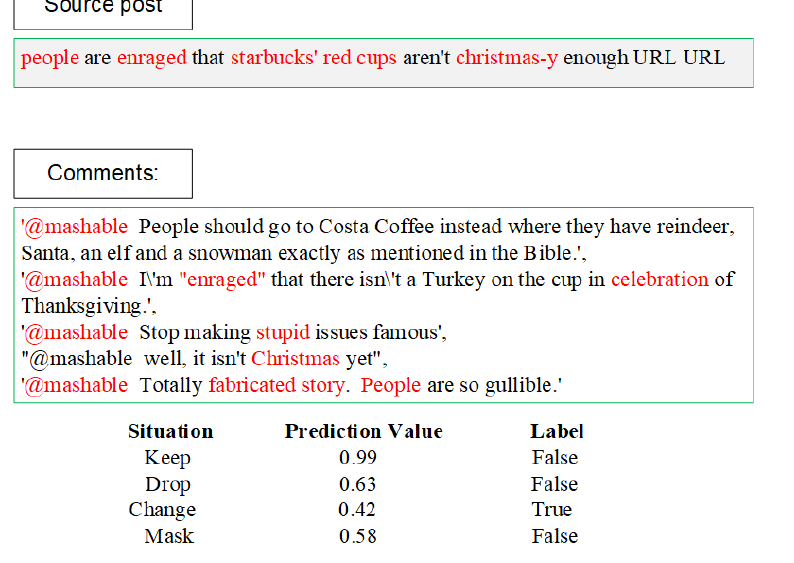
Figure 5. The case study of interpretability on word-level co-attention. The red words are the top 10 attention words and it also shows the value of prediction under different